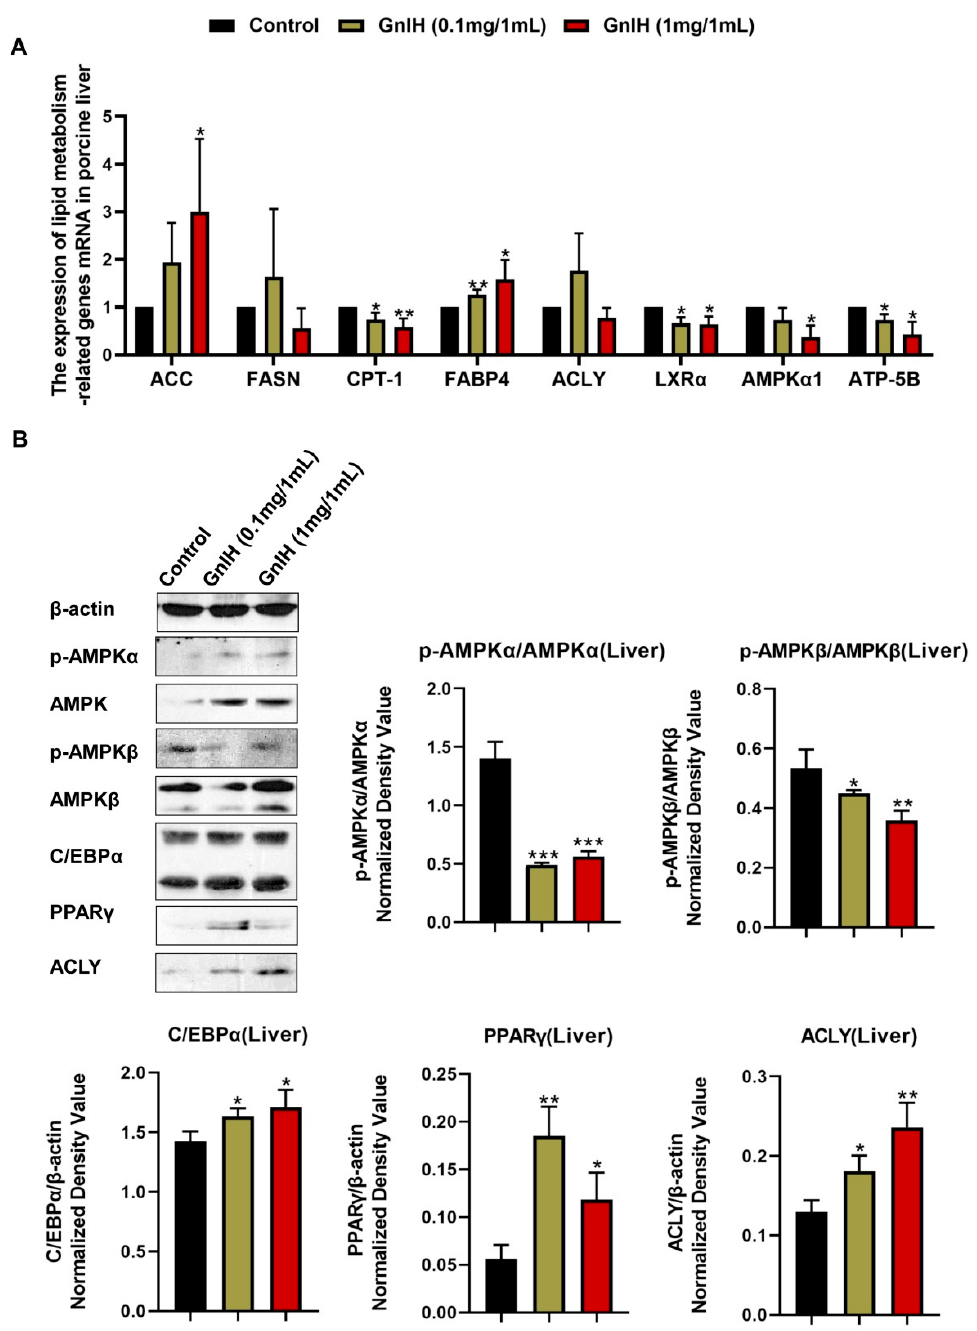
Figure 6. ( A ) The mRNA expression levels of hepatic lipid metabolism-related genes in liver of piglets administered different chronic doses of GnIH or vehicle for 14 days. ACC , FASN and ACLY as key lipogenic enzymes, CPT-1 as critical lipolytic enzyme, LXR α as main cholesterol metabolizing enzyme, FABP4 as a key lipid transporter, AMPK α 1 and ATP-5B as critical energy metabolism genes were selected to detect by relative RT-PCR. ( B ) Effect of intraperitoneally injected GnIH on AMPK and downstream signaling cascade in the liver of piglets administered different chronic doses of GnIH or vehicle for 14 days. Densitometric quantification of p-AMPK α and p-AMPK β levels was performed after normalization to total AMPK α and AMPK β levels as loading controls while the densitometric quantification of C/EBP α , PPAR γ and ACLY was performed after normalization to β -actin levels as loading controls, respectively. n = 3 independent experiments. The data are shown as the means ±SEM. * p < 0.05, ** p < 0.01 and *** p < 0.001 GnIH vs. vehicle.